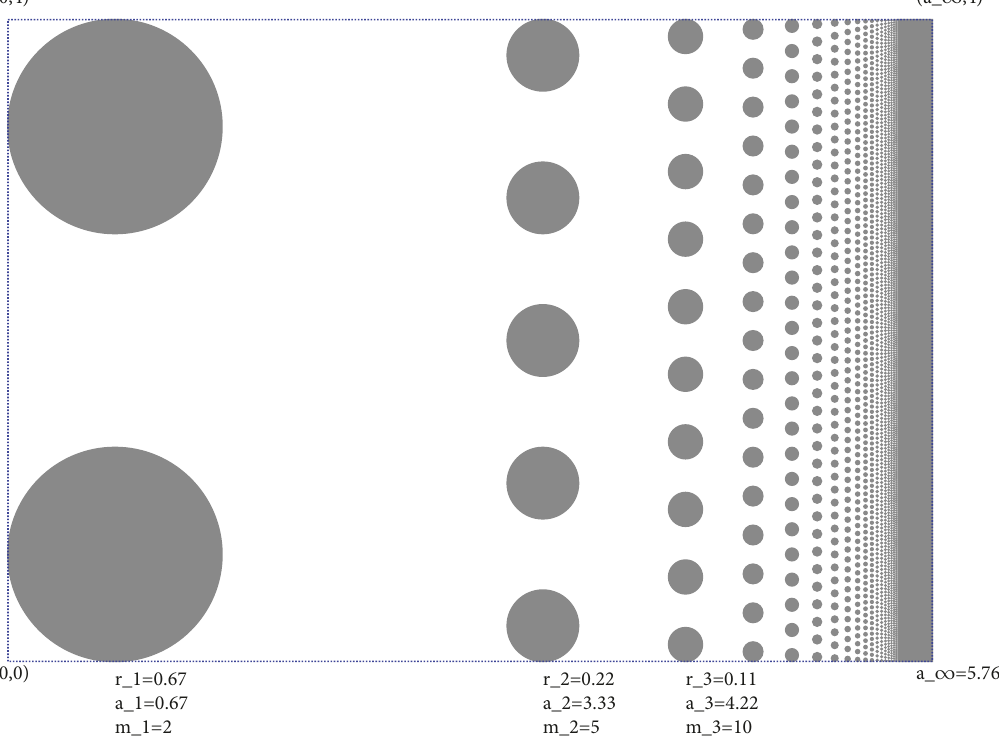
Figure 6: Compact set 𝐶 (in gray) from Example 2 with 𝑚 ℎ = 1+ℎ 2 . (The blue, dotted rectangle has corners (0,0) and (𝑎 ∞ , 4) and is not part of 𝐶